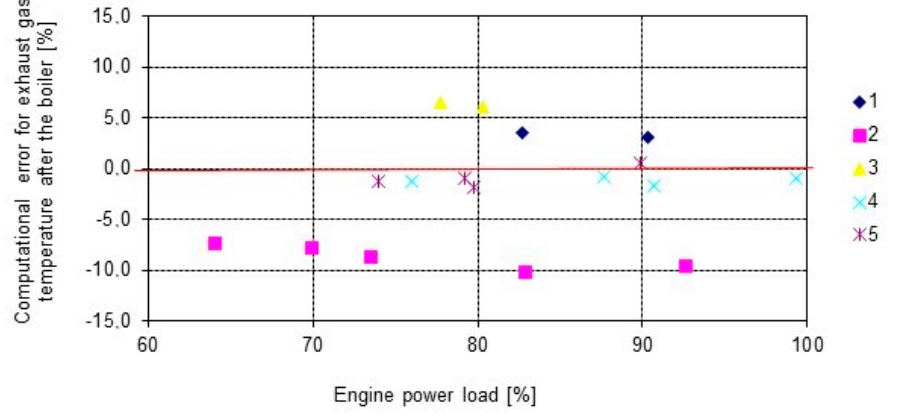
Figure 10. Computational error for exhaust gas temperature after the boiler.